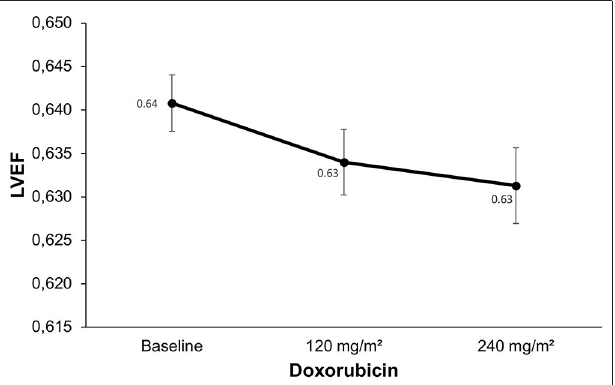
FIGURE 2 | Changes in left ventricle ejection fraction (LVEF) during the treatment. Compared to baseline, LVEF did not change during the chemotherapy with doxorubicin ( p = 0.178).